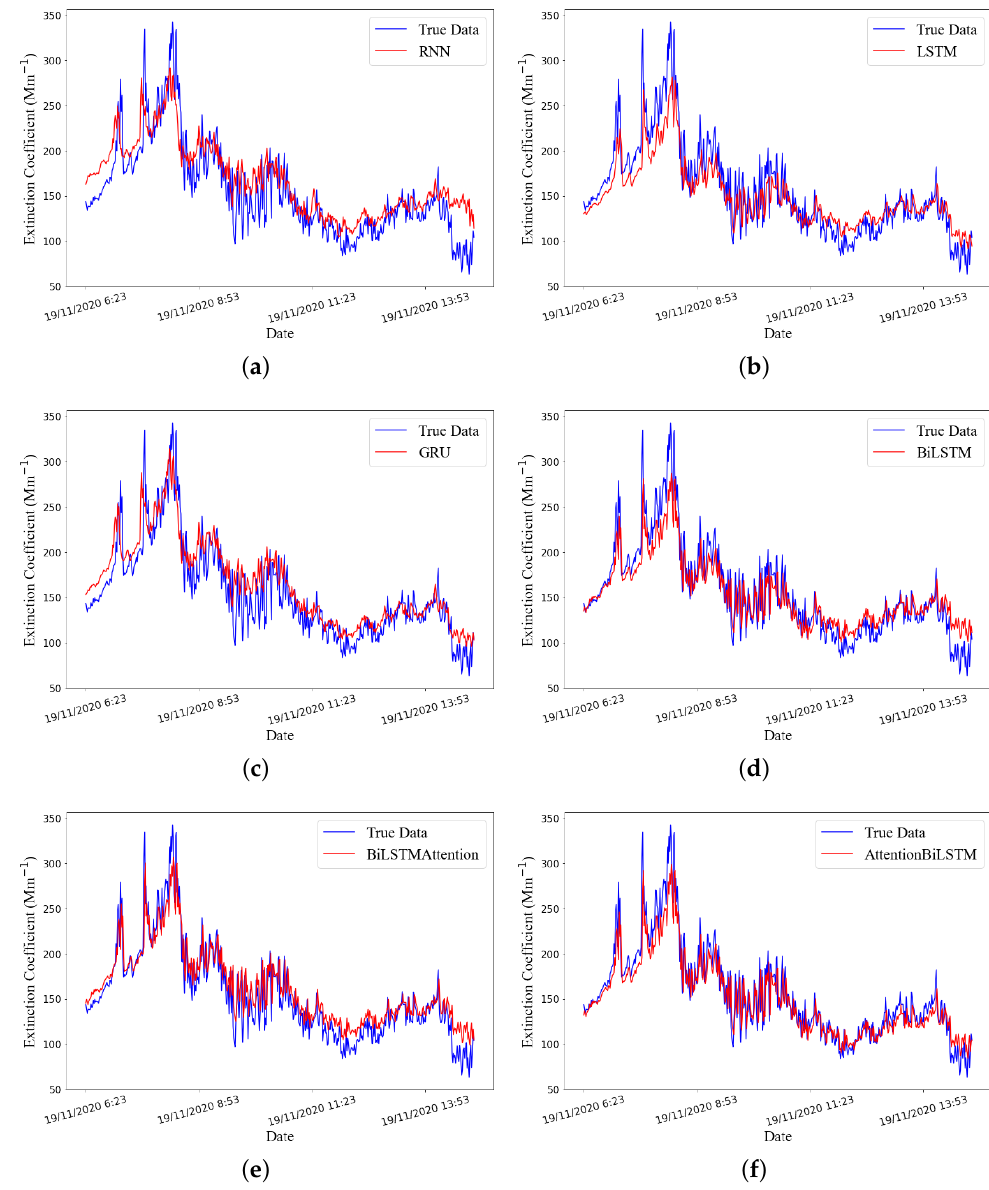
Figure 10. The performance of prediction in dataset A by using ( a ) RNN, ( b ) LSTM, ( c ) GRU, ( d ) BiLSTM, ( e ) BiLSTMAttention, and ( f ) Proposed